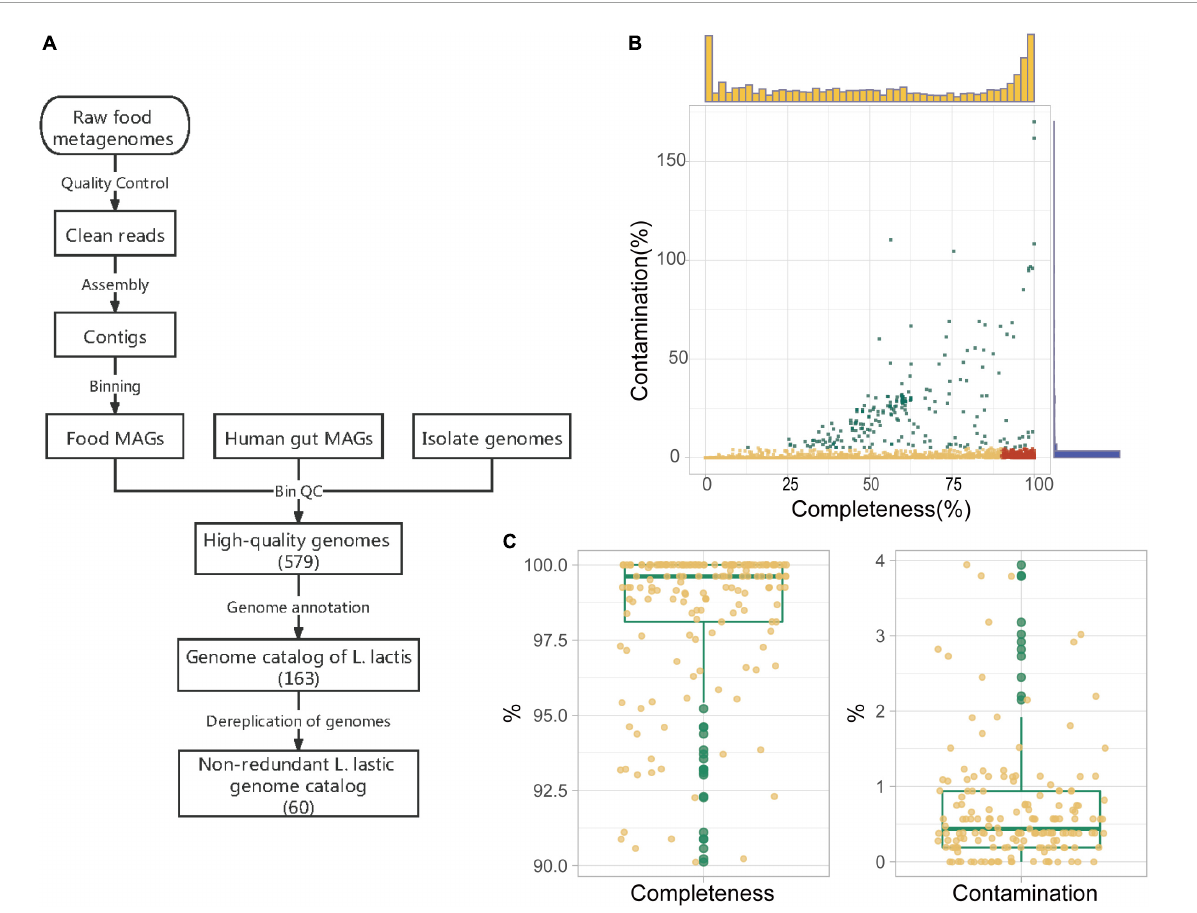
FIGURE3 Construction and quality assessment of genome catalog Lactococcus lactis . (A) The pipeline for the construction of L. lactis genome catalog. Reads quality control, assembly, and binning were performed on food metagenomes to gain food microbiota metagenome-assembled genomes (MAGs). Then we carried out genome quality assessment over all genomes (including the human gut and food microbiota MAGs and isolate genomes). All high-quality genomes (Completeness > 90% and contamination < 5%) were incorporated together for genome annotation. In the end, there were 163 genomes belonging to Lactococcus lactis , and the number of non-redundant genomes was 60. (B) Completeness and contamination values of 2,086 food metagenomic bins. High-quality, medium-quality, and low-quality food microbiota MAGs were marked in red, yellow, and green, respectively. Marginal histograms added on the X and Y-axis represent frequencies of bins corresponding to different completeness (yellow) /contamination (blue) values. (C) Quality of 163 L. lactis genomes in our genome catalog. Box lengths represent the IQR of the data, and the whiskers represent the lowest and highest values within 1.5 times the IQR from the first and third quartiles,